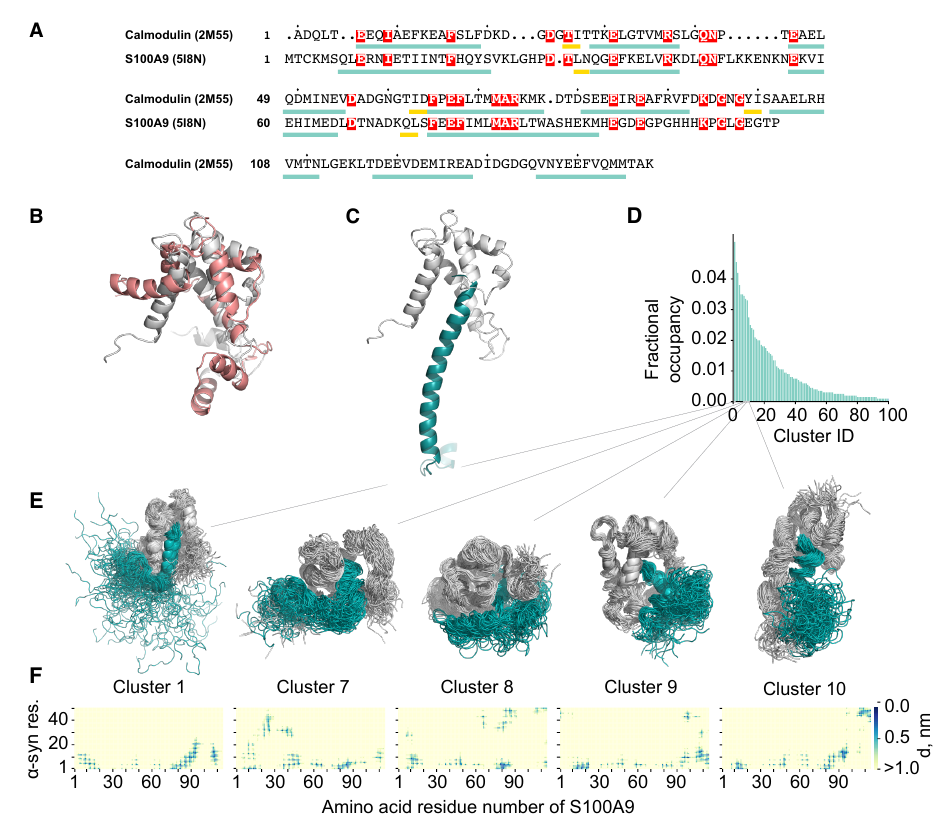
Figure 4. ( A ) S100A9 and calmodulin sequence and secondary structure alignment. Teal rectangles represent α -helixes; yellow rectangles represent β -sheets. Identical residues are shaded in